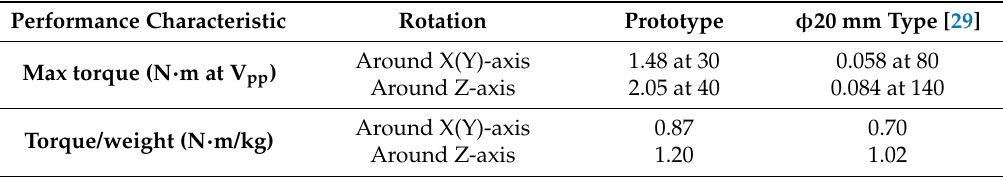
Table 4. Comparison of torque performance between prototype and φ 20 mm type.